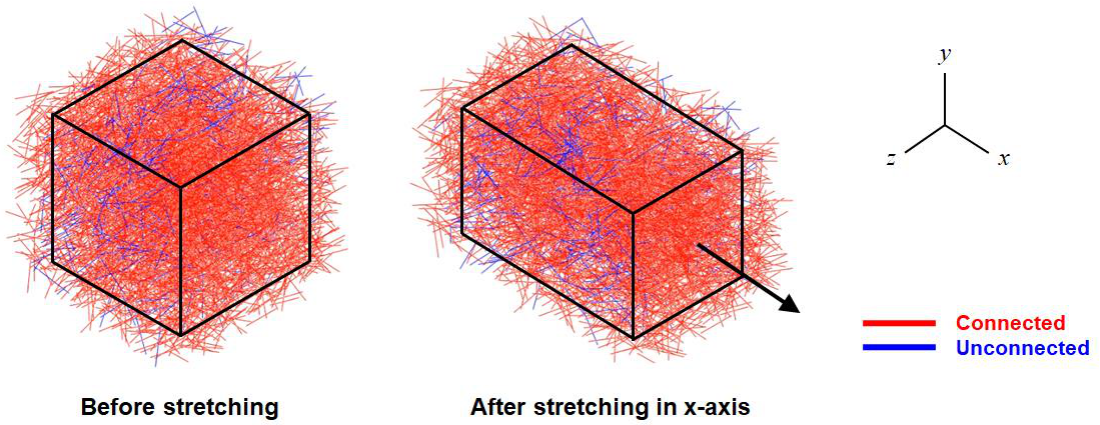
Figure 12. 3D resistance network models before and after uniaxial tension in the x-axis at a stretch of 1.4.